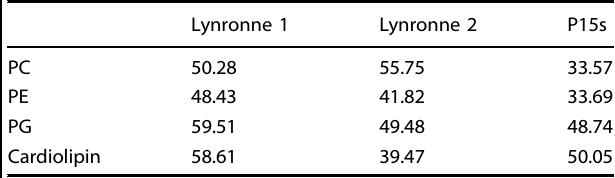
Table 3. Critical pressure of insertion of Lynronne 1, Lynronne 2 and P15s into pure lipids present in the external lea fl et of bacterial and eukaryotic cell